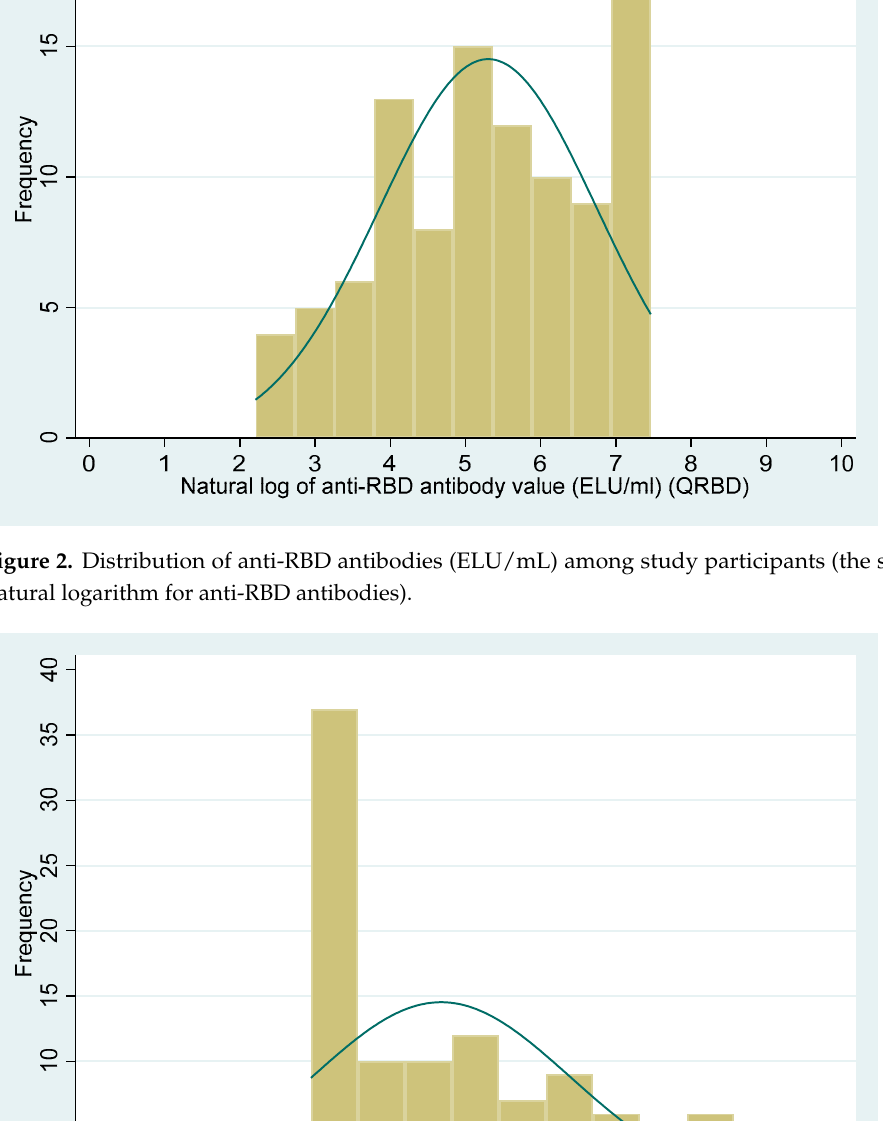
Figure 4. Scatter plot of anti-RBD antibodies (ELU/mL) among participants with neutralizing anti- body titres (The scales are natural logarithms).